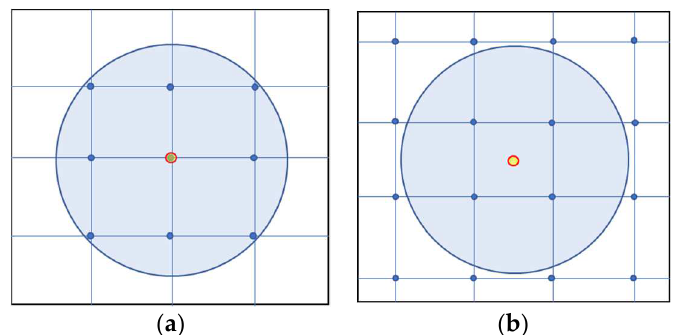
Figure 5. Location estimation point proximity area selection range. ( a ) Situation 1 and ( b ) Situation 2.